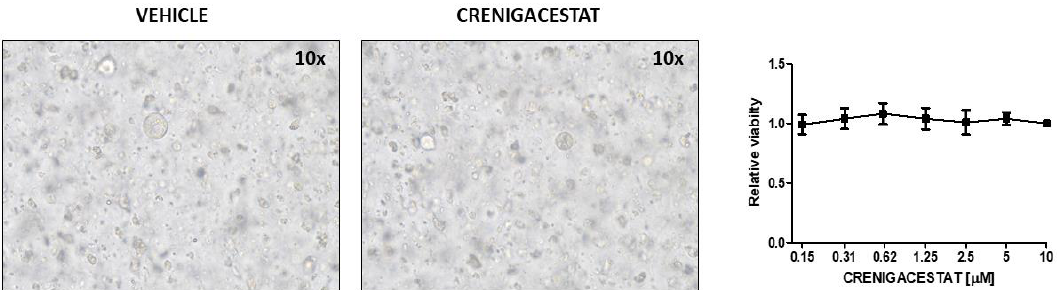
Figure 9. Crenigacestat has no effect on iCCA-PDOs. Phase-contrast images of two wells treated with DMSO or Crenigacestat (10 µ M). Dose–response curves of Crenigacestat after 15 days show no difference in relative viability. Viability values are expressed as mean ± SEM.